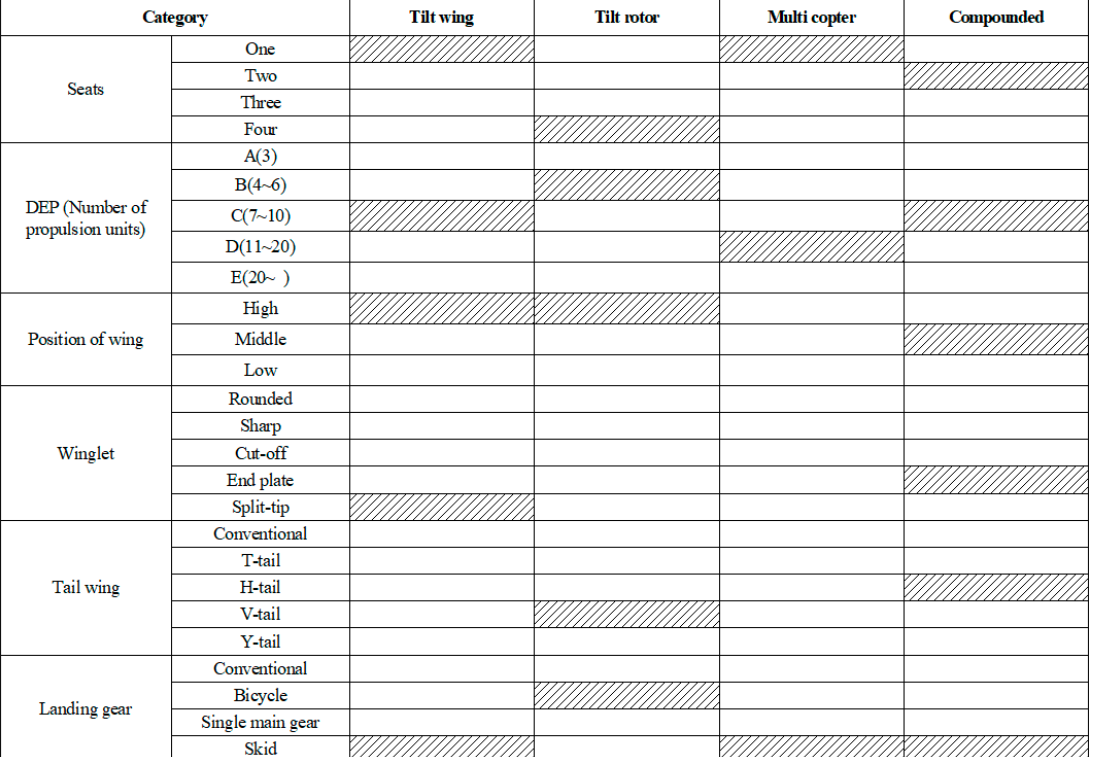
Table 14. Design space of design parameters.